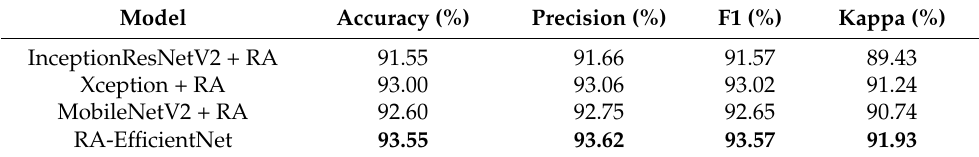
Table 7. Comparison of different CNN networks and RA block for Task 2.